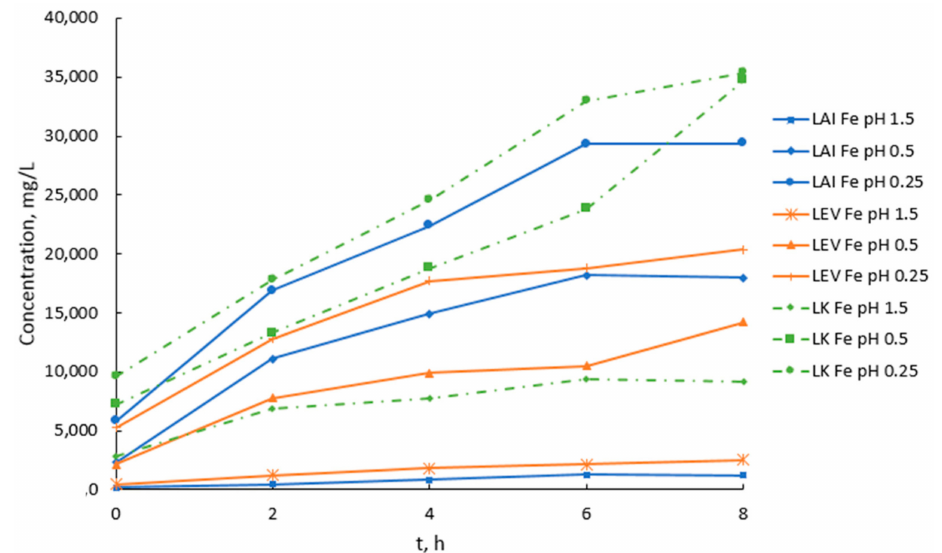
Figure 3. Evolution of Fe concentration vs. time during leaching of LAI, LEV, and LK laterites in pH 0.25, 0.5 and 1.5. Parameters used in the experiments: 90 ◦ C, S / L = 30%, 800 rpm. pH was maintained by H 2 SO 4